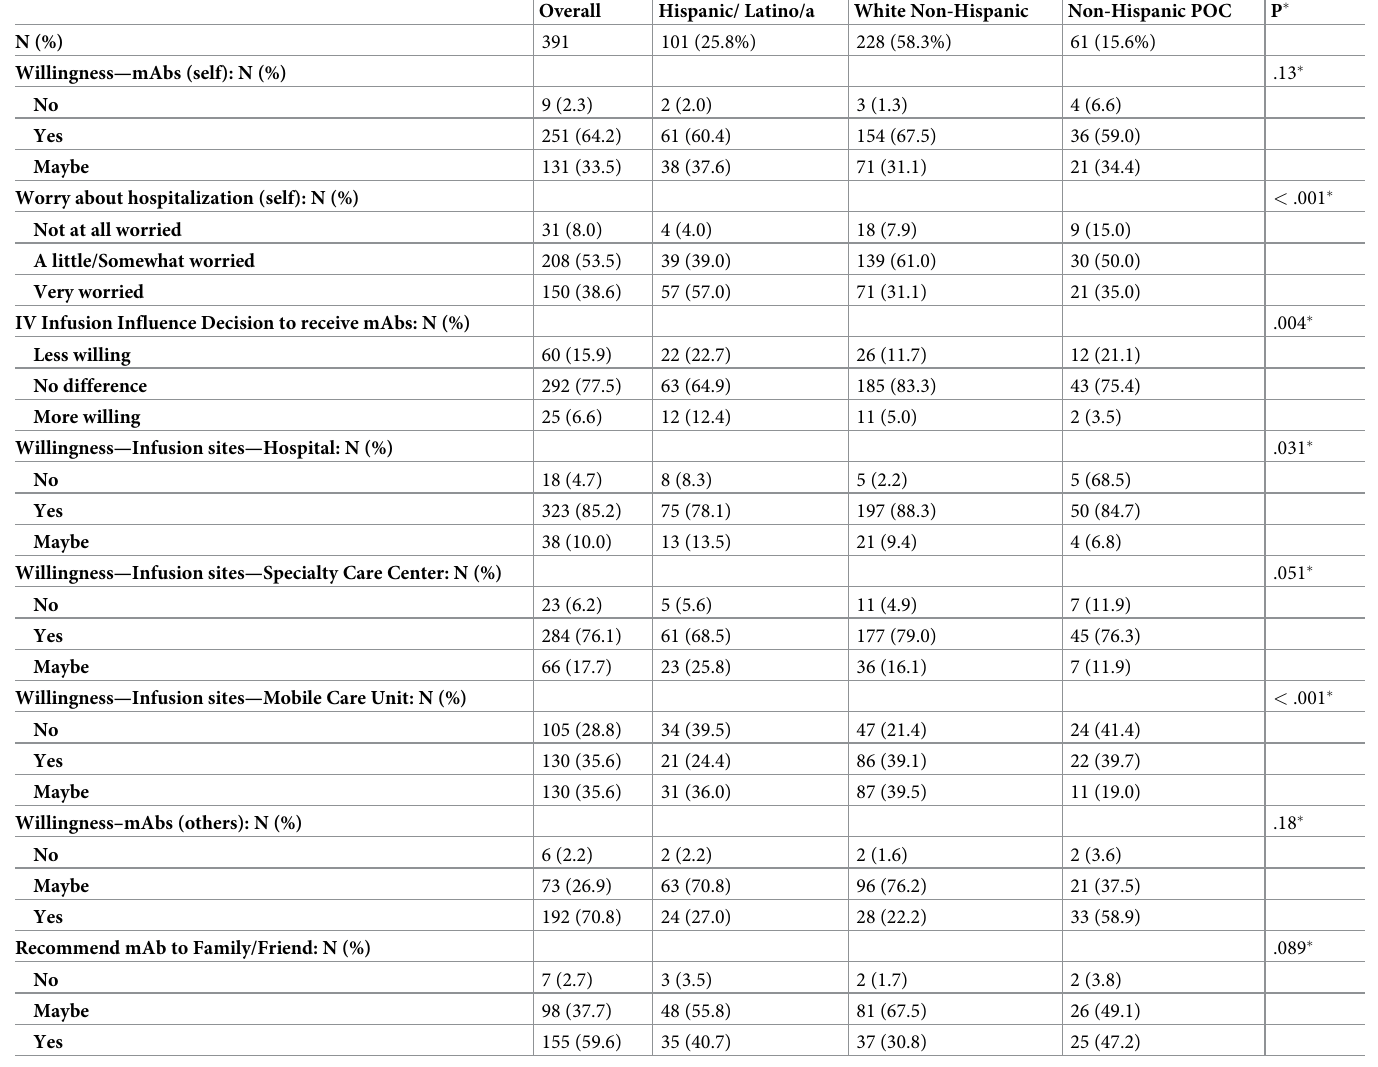
Table 4. Willingness to receive monoclonal antibody treatment for COVID-19 for Self and Others by